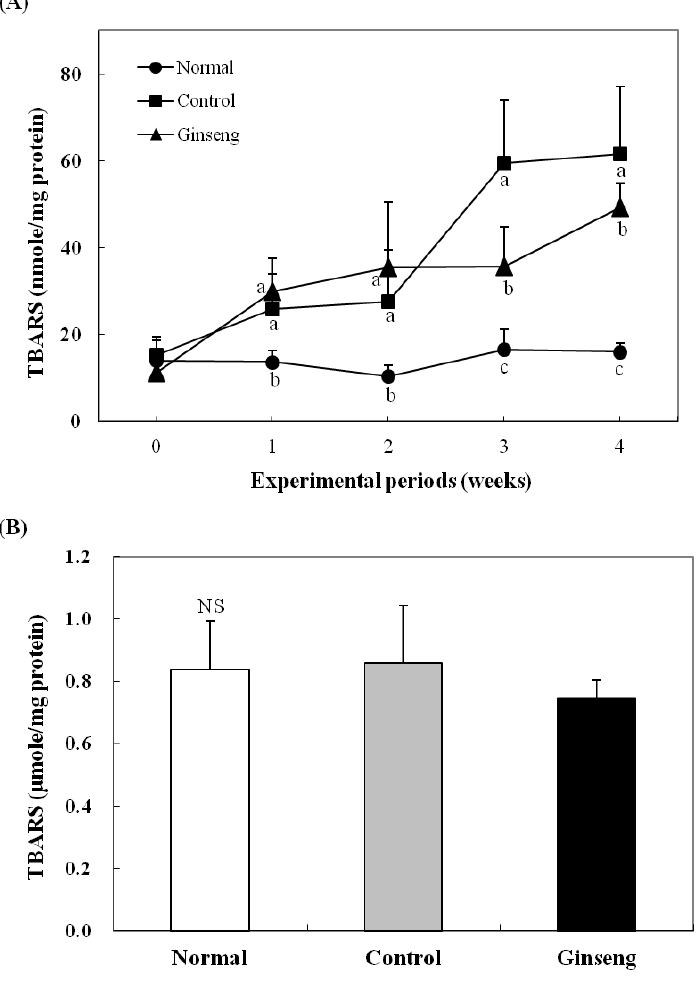
different by ANOVA with Duncan’s multiple range test at p < 0.05 (NS; not significant). Normal diet; Control, high cholesterol diet; Ginseng, high-cholesterol diet containing 0.05% white ginseng low-molecule